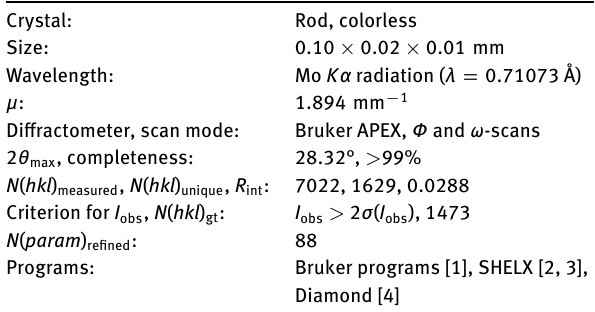
Table 1: Crystal collection and handling.